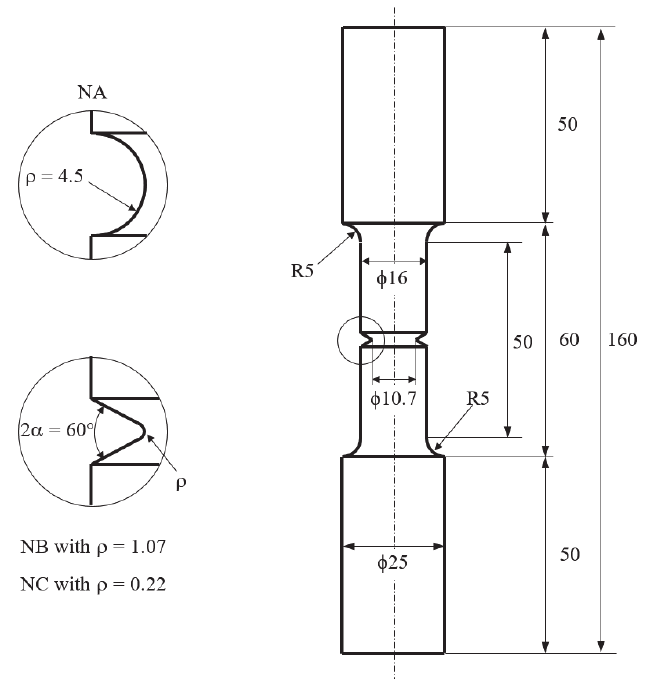
Figure 1: Geometry of the cylindrical notched specimens [13] (dimensions are in